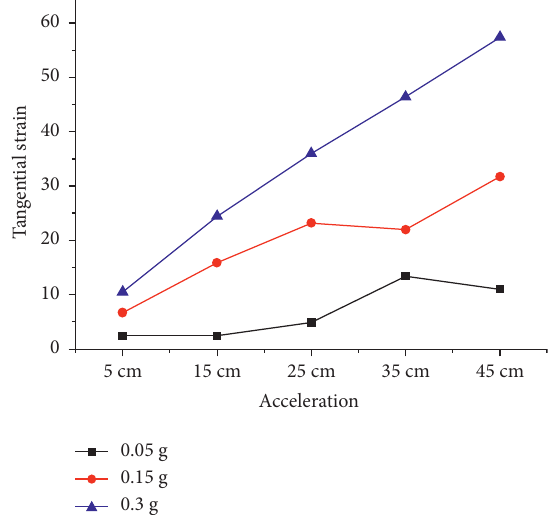
Figure 16: Longitudinal strain curve of vault exterior